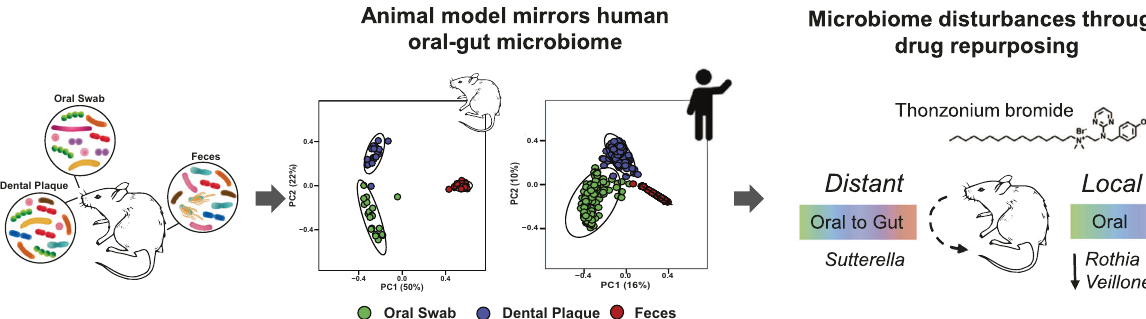
Fig. 5 Oral-gut microbiome rodent model and microbiota disturbances by thonzonium bromide. Gastrointestinal microbiome differs between oral-gut body sites. Our rodent model showed similar pattern of the microbial communities in oral (oral swab and dental plaque) and gut (feces) sites in human reported previously. This model was then applied to assess the impact of thonzonium bromide in the host microbiota; topical oral treatment caused localized microbiome disturbances while promoting turnover of speci fi c oral species in the gut